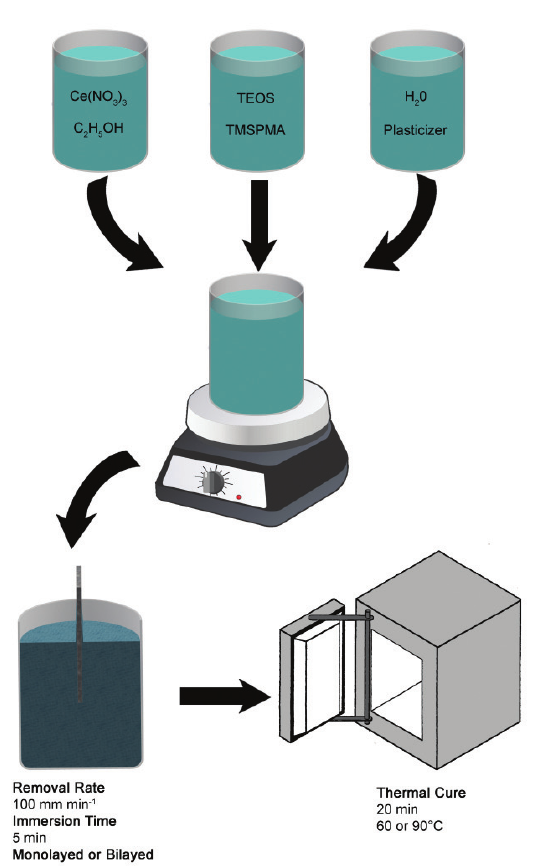
Figure 1. Experimental parameters of synthesis of the sols and processing to deposit